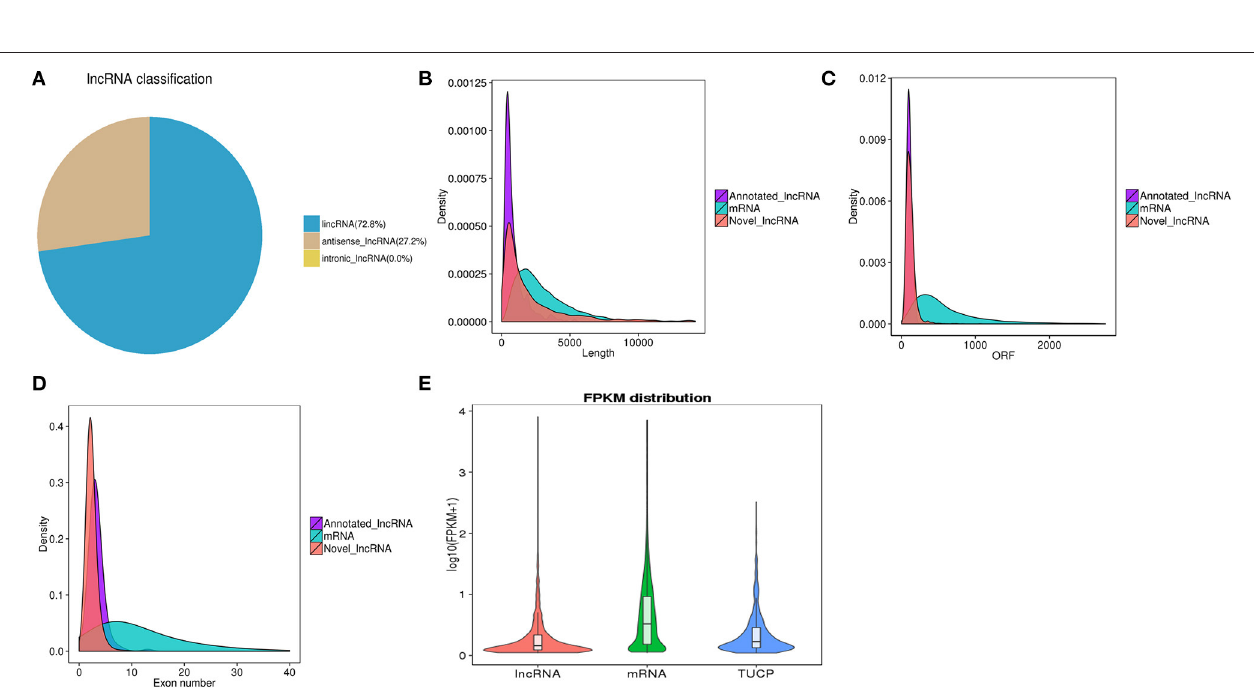
FIGURE 1 | (A) Identification pipeline for lncRNAs in olive flounders. (B) The numbers of candidate transcripts at five filtering stages.